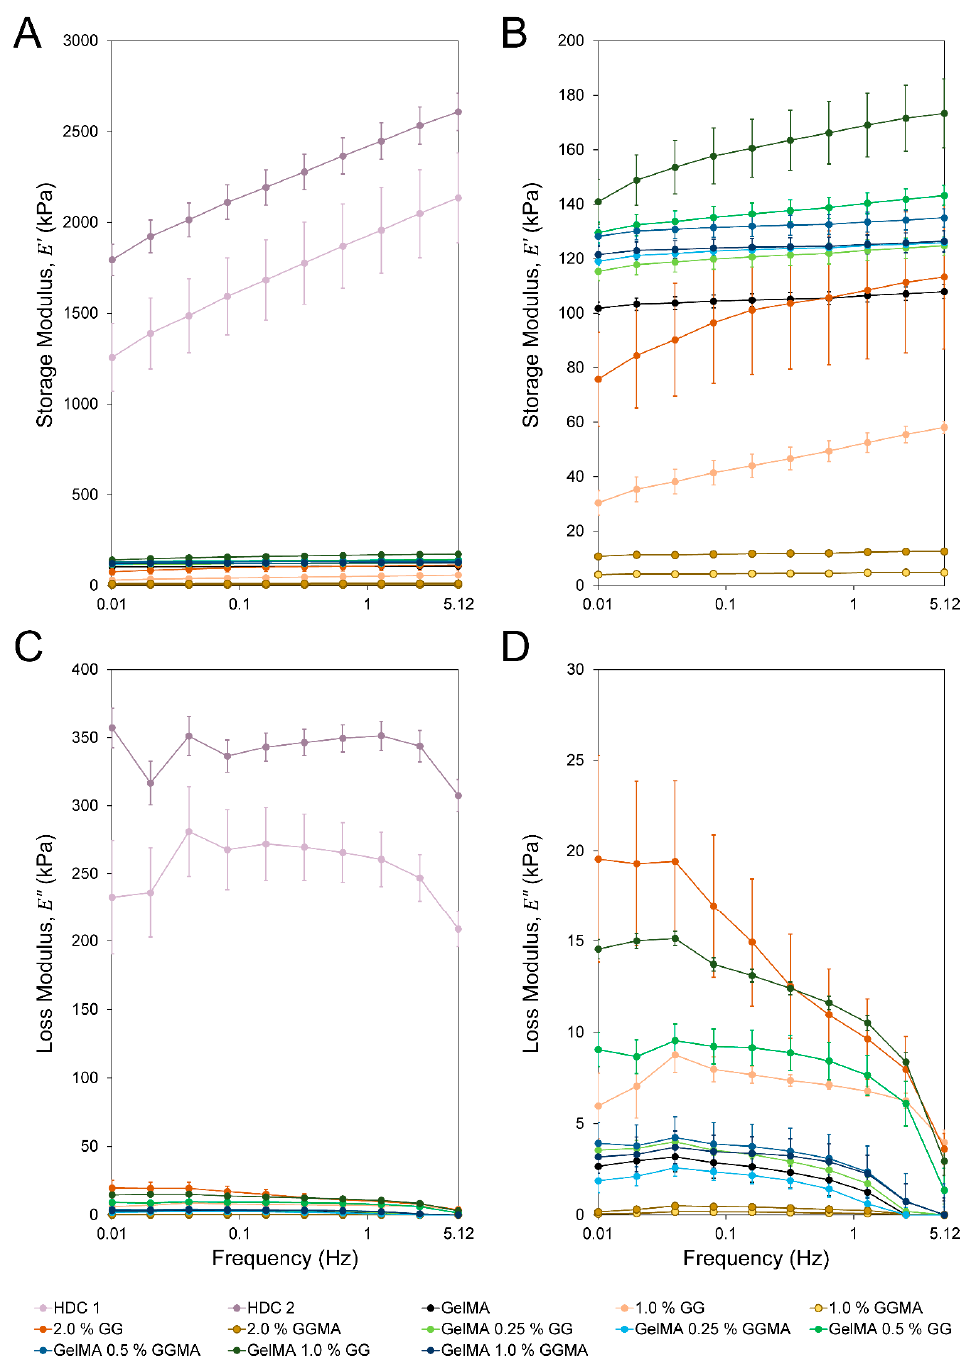
Figure 5. Storage and loss moduli of single hydrogel components, hydrogel blends and human donor tissue explants across the tested frequency range, shown in log 10 scale. Storage moduli of ( A ) all mechanically tested groups; ( B ) hydrogel groups with explant samples omitted; Loss moduli of ( C ) all mechanically tested groups; and ( D ) hydrogel groups with explant samples omitted. In each case the mean of n = 5 samples is presented with error bars indicating standard error of the mean.